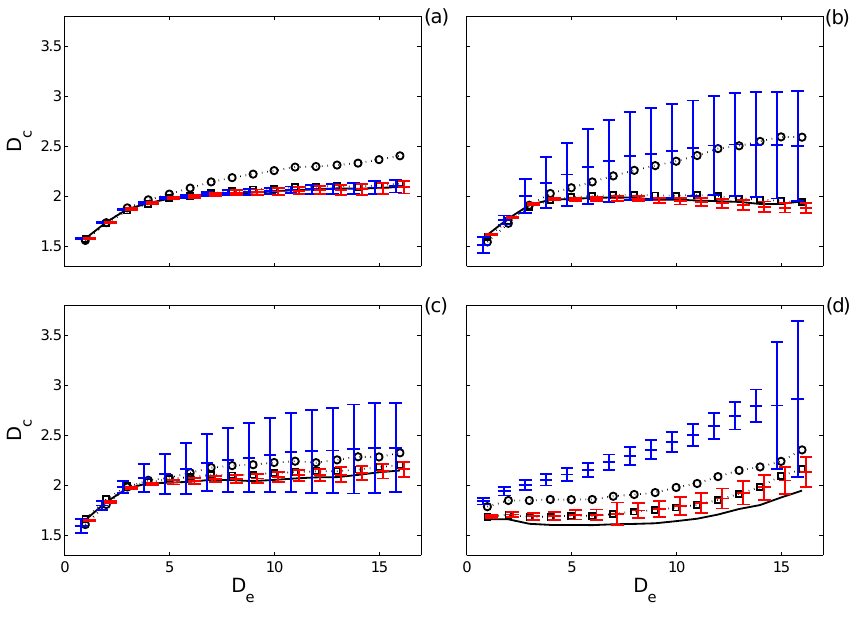
Fig. 9. The correlation dimension, D c , as a function of embedding dimension, D e , for the Lorenz system and surrogates with R = 24 . 29 (a) , R = 24 . 75 (b) , R = 28 . 00 (c) , and R = 167 . 0 (d) . The results for the Lorenz system are given by a black line, with those for series reconstructed from the fixed wavelet coefficients for ρ = 0 . 99 (dotted line with circles) and ρ = 0 . 999 (dotted line with squares) and surrogate series for ρ = 0 . 99 (blue) and ρ = 0 . 999 (red). The latter summarise results for 19 surrogates according to mean (central horizontal line) and ± 2 standard deviations (vertical lines). They are translated slightly from the integer value for D e for clarity.